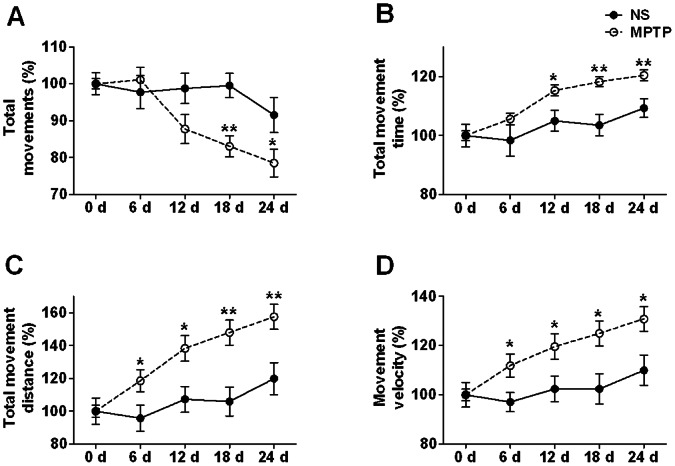
MPTP increases the spontaneous locomotor activity.(A) Total movements. (B) Total movement time. (C) Total movement distance. (D) Movement velocity. Filled circle with solid line represents the NS group, and hollow circle with dash line represents the MPTP group. *p<0.05, **p<0.01 vs. NS group on the same day. n = 10∼11.